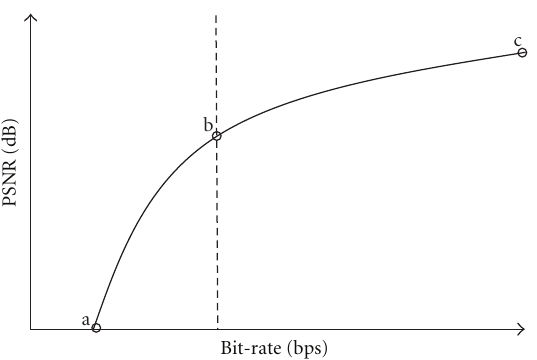
Figure 1: Rate-distortion behavior of an encoded video.